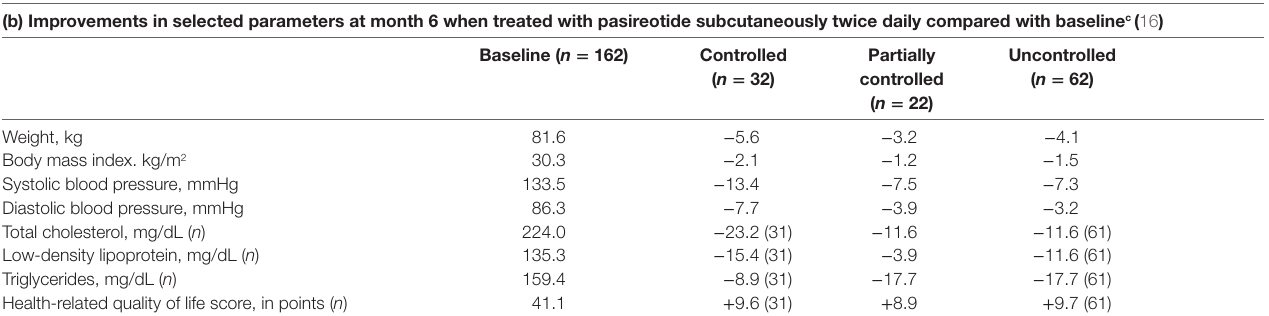
a Unless otherwise stated. b Values are based on calculated weighted averages of data provided in the primary articles. c Controlled patients achieved urinary free cortisol (UFC) ≤ upper limit of normal (ULN), partially controlled patients had UFC ≥ ULN but with > 50% decrease from baseline, and uncontrolled patients did not have UFC ≤ ULN and who did not achieve > 50% decrease from baseline. Regardless of their status, all groups demonstrated tangible improvements